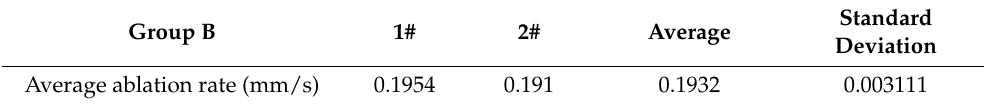
Table 8. Ablation rate of Group B in whole process (gas phase velocity was 2 m/s).